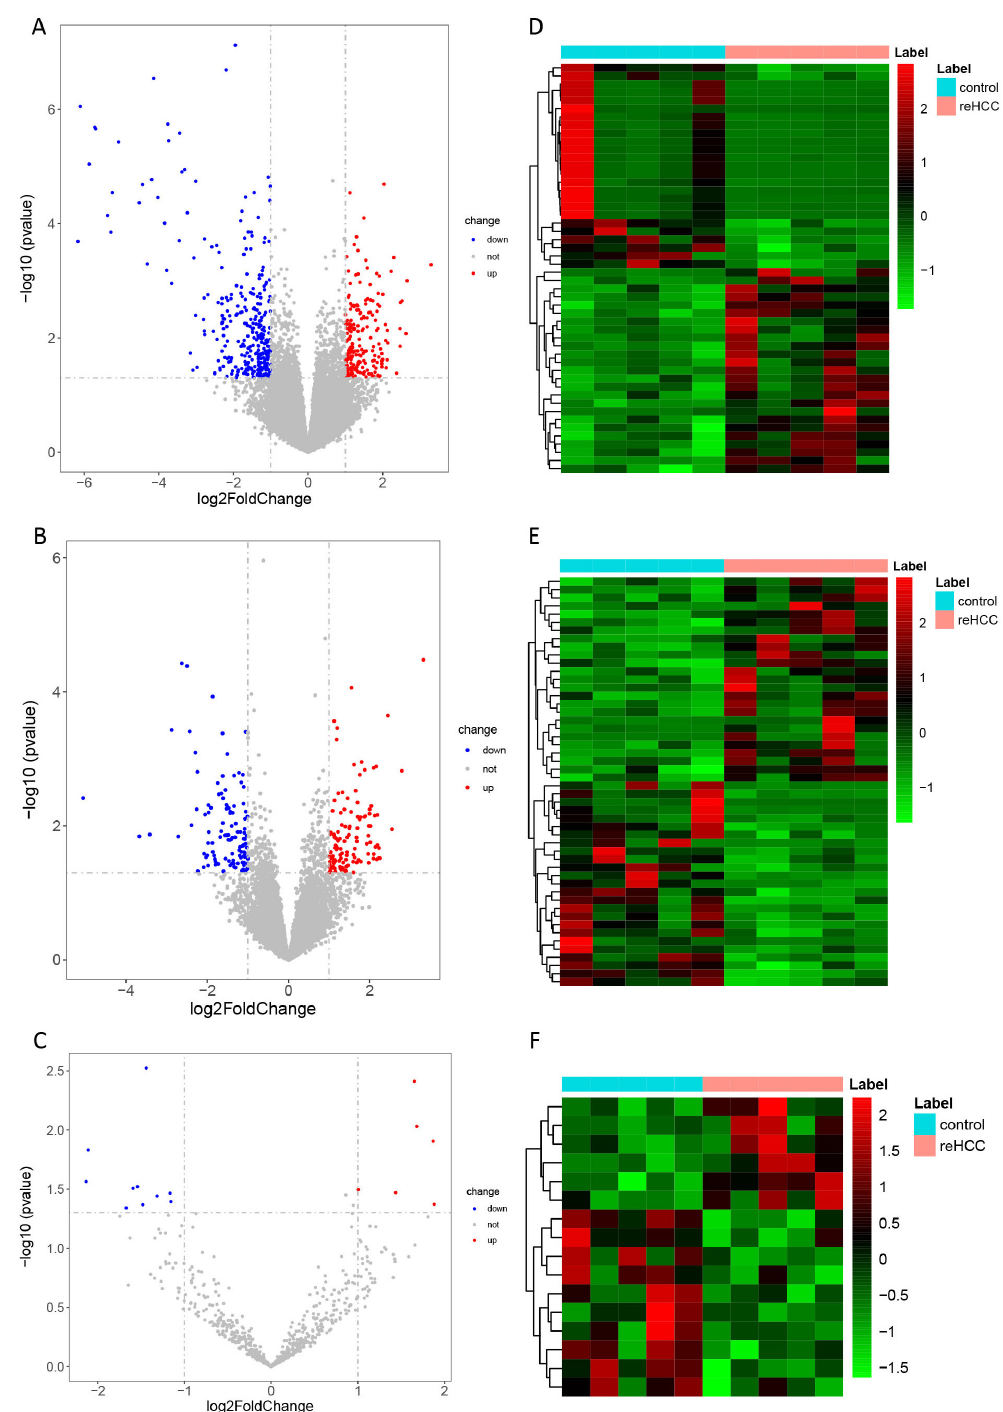
Figure 1. Volcano plot (A–C) and heatmap (D–F) displaying dysregulated mRNAs (A, D), lncRNAs (B, E), and circRNAs (C, F) in HCC recurrence after LT. Rows and columns represent DEmRN As/DE lncRN As/DE circR NAs and samples, respectively. The color scale represents the expression levels. circRNAs, circular RNAs; DE, differentially expressed; HCC, hepatocellular carcinoma; lncRNAs, long non-coding RNAs; LT, liver